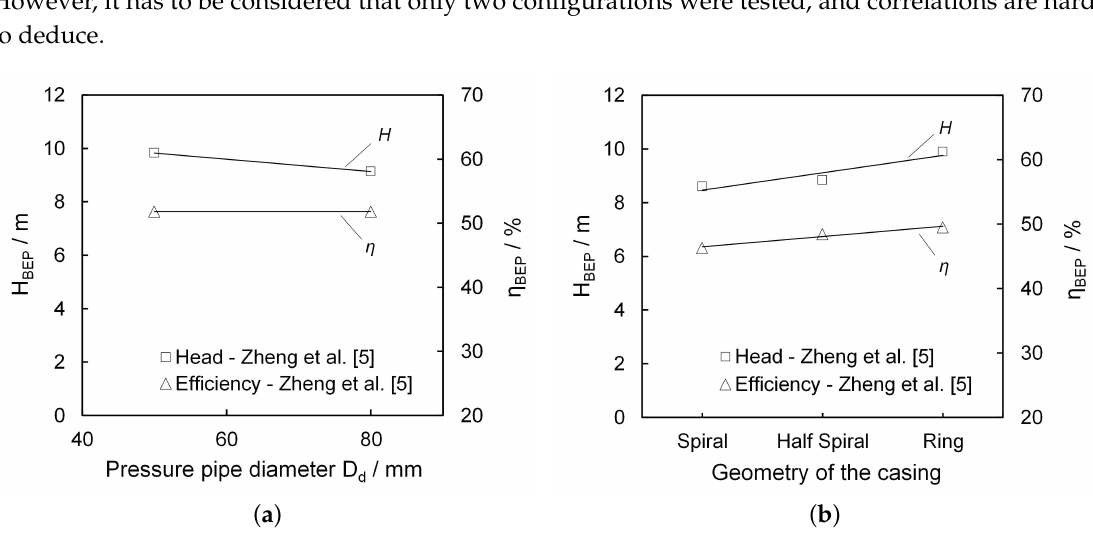
Figure 20. ( a ) Head and efficiency over pressure pipe diameter; and ( b ) head and efficiency for different geometries of the